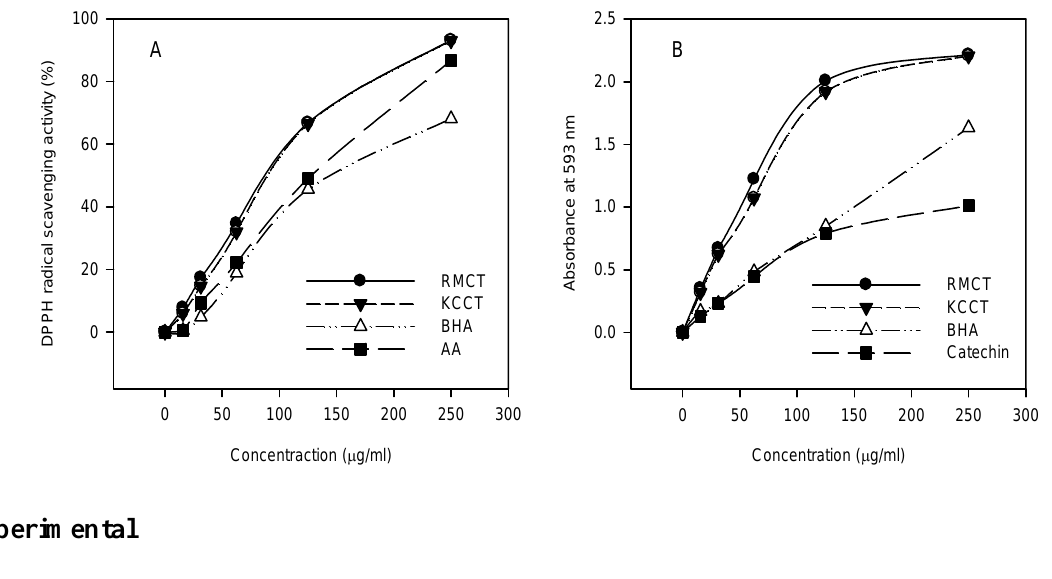
Figure 3. DPPH radical scavenging activity (A) and reducing power (B) of RMCT, KCCT and reference standards at different concentration. RMCT and KCCT were respective condensed tannins from R . mangle and K . candel